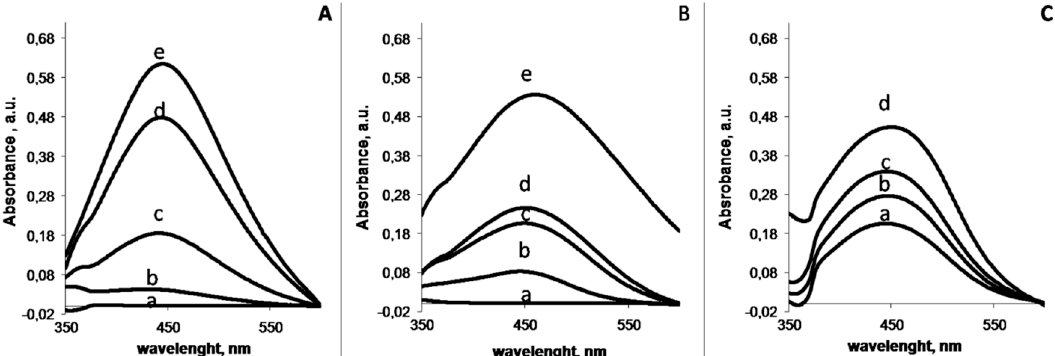
Figure 2. UV ‐ Vis spectra of silver ‐ containing chondroitin sulphate solutions (CS 10 wt. % and 0.16 mM AgNO 3 ) after thermal treatment at 80 °C ( a ) and 90 °C ( b ) and UV ‐ treatment ( c ). Thermal treatments were performed over 0, 90, 120, 210 and 270 min (lines a, b, c, d and e, respectively). UV treatments were performed over 120, 180 and 240 min (lines a, b and c). Sample irradiated during 240 min rested 24 h before measuring the exciton peak (line d).